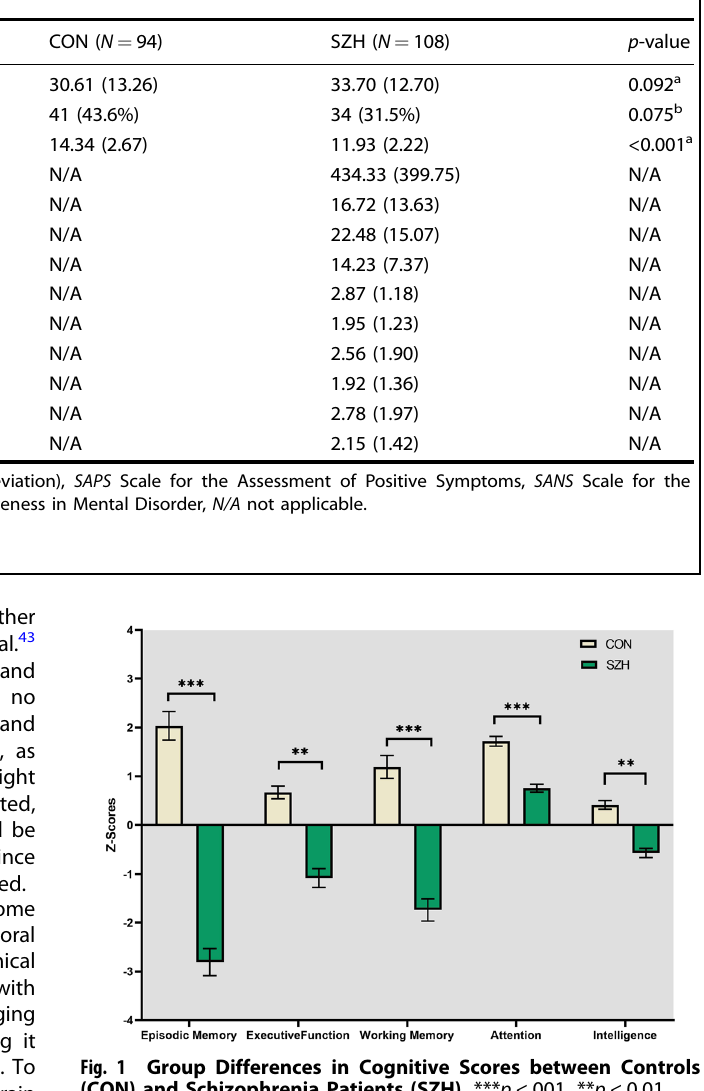
Table 1. Demographic characteristics of the sample.